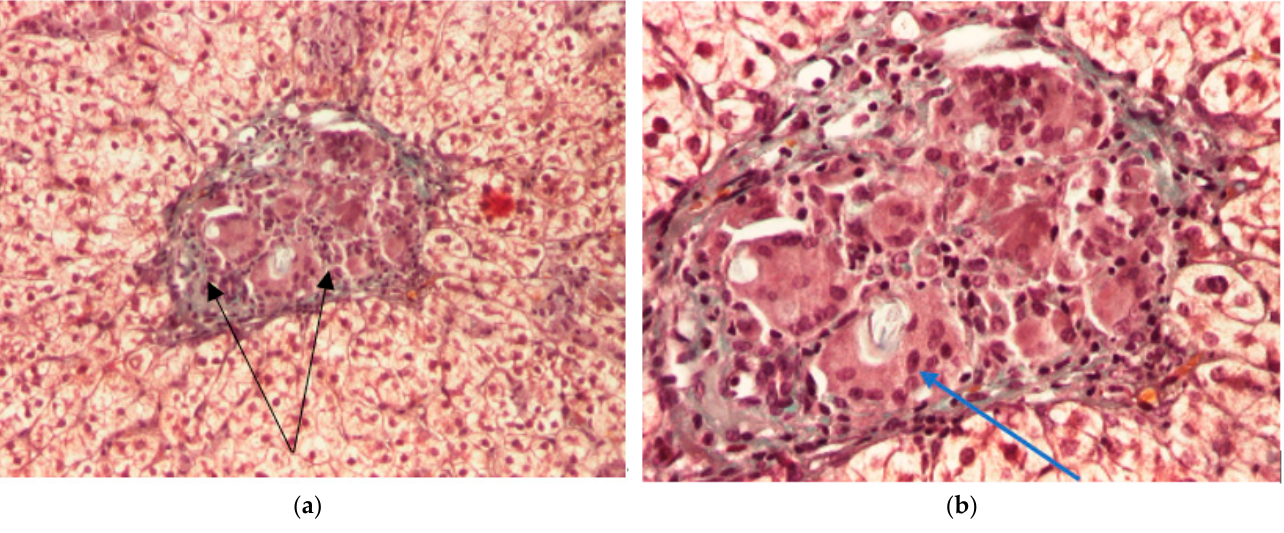
Figure 6. ( a ) Szekely trichrome staining ×100, ( b ) Szekely trichrome staining ×200. Liver biopsy: tight, well-formed epithelioid granuloma of sarcoidosis, not directed at the bile duct. There is a cuff of lymphocytes (black arrows) and Langhans giant cell, with the nuclei arranged in a ring along the periphery (blue arrow). Even not specific, Langhans type giant cells are characteristic of sarcoidosis (personal collection, St. Mary Emergency Children’s Hospital, Iasi).